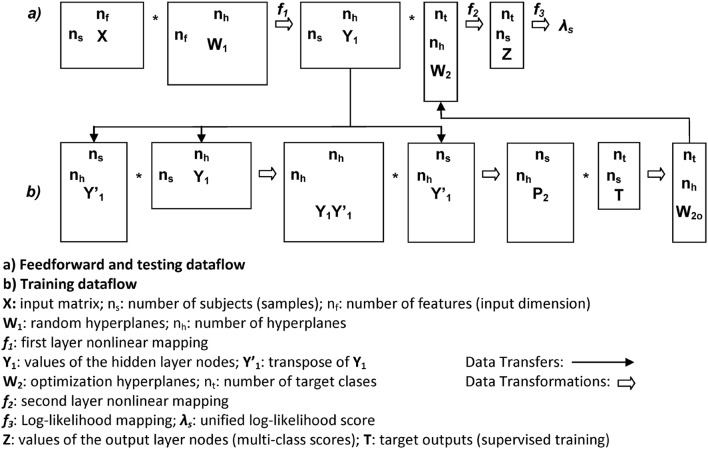
Data structures and flow of the RLSFN. Matrix dimensions are annotated close to rectangle sides (rows to vertical, columns to horizontal).